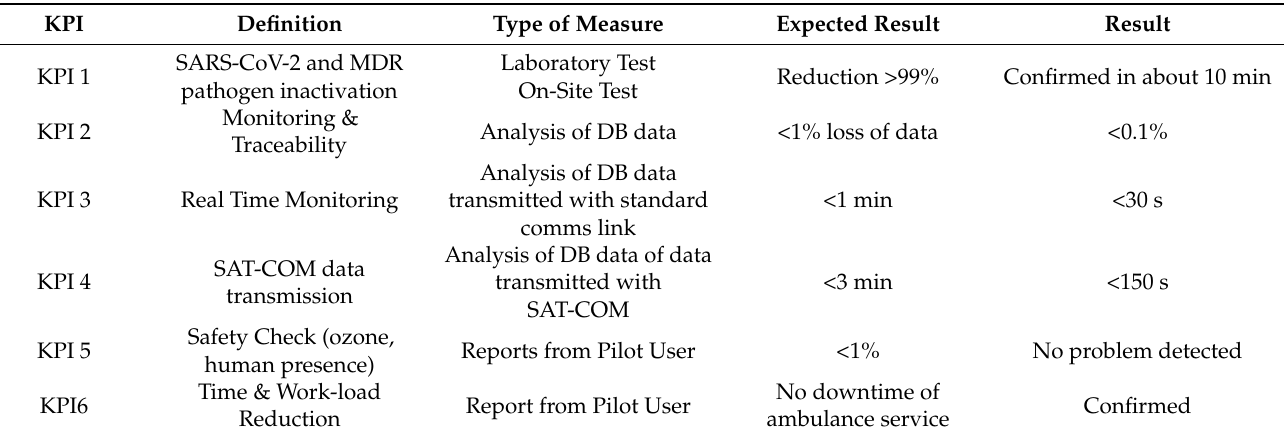
Table 4. Key Performance Indicators evaluation.